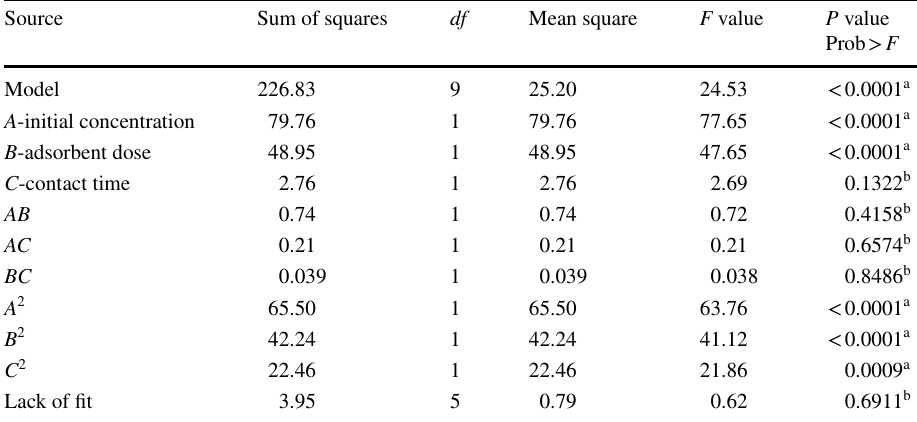
Table 5 ANOVA for MOD removal surface quadratic model